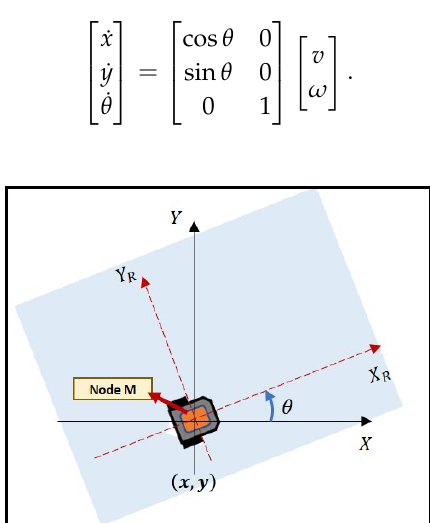
Figure 3. Overview of mobile robot in [ X , Y ] and [ X R , Y R ]